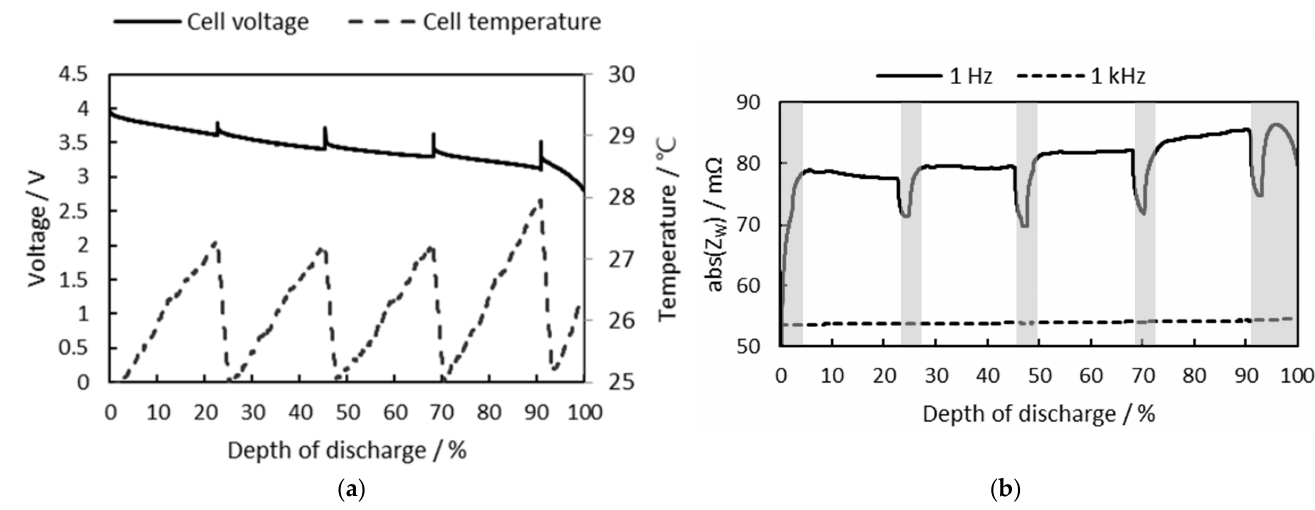
Figure 11. ( a ) Cell voltage (solid line) and cell temperature (dotted line) vs. DoD; ( b ) 1 Hz impedance (solid line) and 1 kHz impedance (dotted line) vs. DoD.